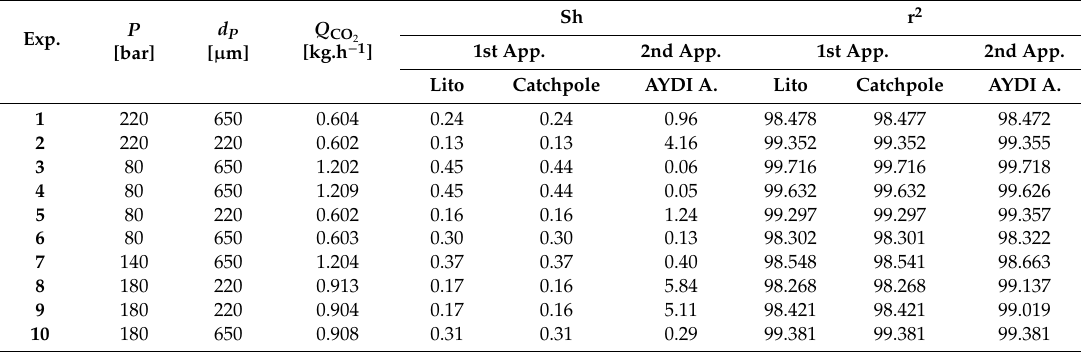
Table 11. Number and the coe ffi cient of determination r 2 between two